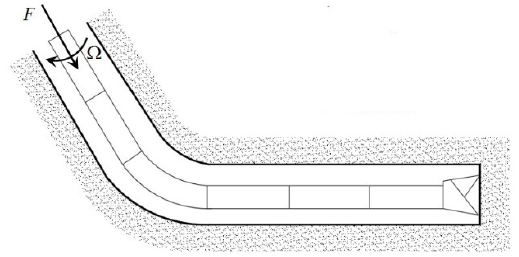
Figure 5. Boundary conditions.